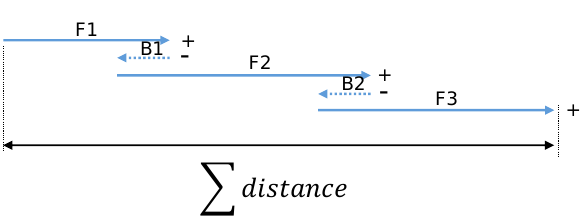
Figure 5. An example of a moving sequence of the capsule robot. F 1 , F 2 , and F 3 represent the capsule robot’s movements forward, and B 1 and B 2 represent the process of the robot’s movements backward.